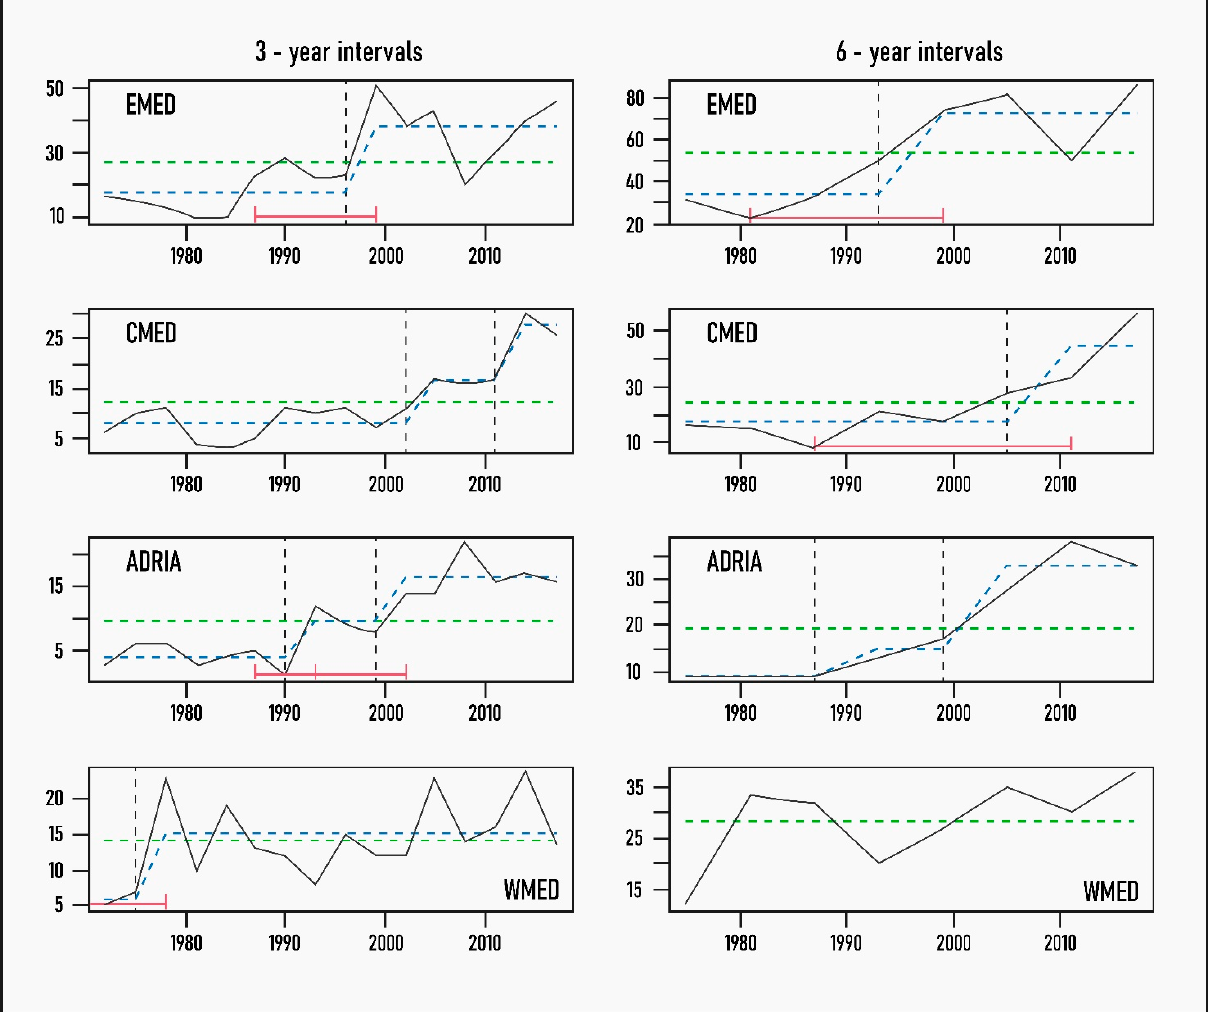
Figure 3. Trends in new NIS introductions, excluding Lessepsian fishes and parasites, in different Mediterranean subregions by 3- and 6-year increments (continuous black line) with breakpoints and fitted mean values superimposed: vertical dashed line indicates breakpoint or year of significant change in the mean values of new NIS, with 95% confidence intervals (CIs) in red brackets; dashed green line shows the null model of no temporal change in new NIS numbers; and dashed blue line represents fitted mean values before and after the identified breakpoint. The absence of red CI bars indicates that 95% CIs could not be computed as they fell outside the data time interval.